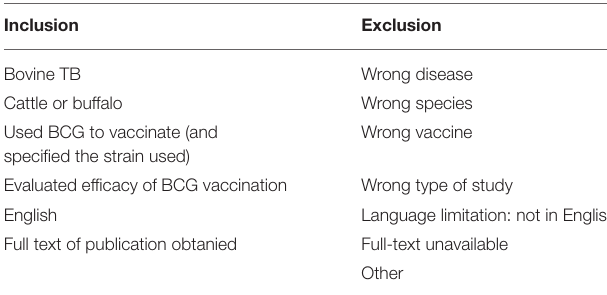
TABLE 4 | Study inclusion/exclusion